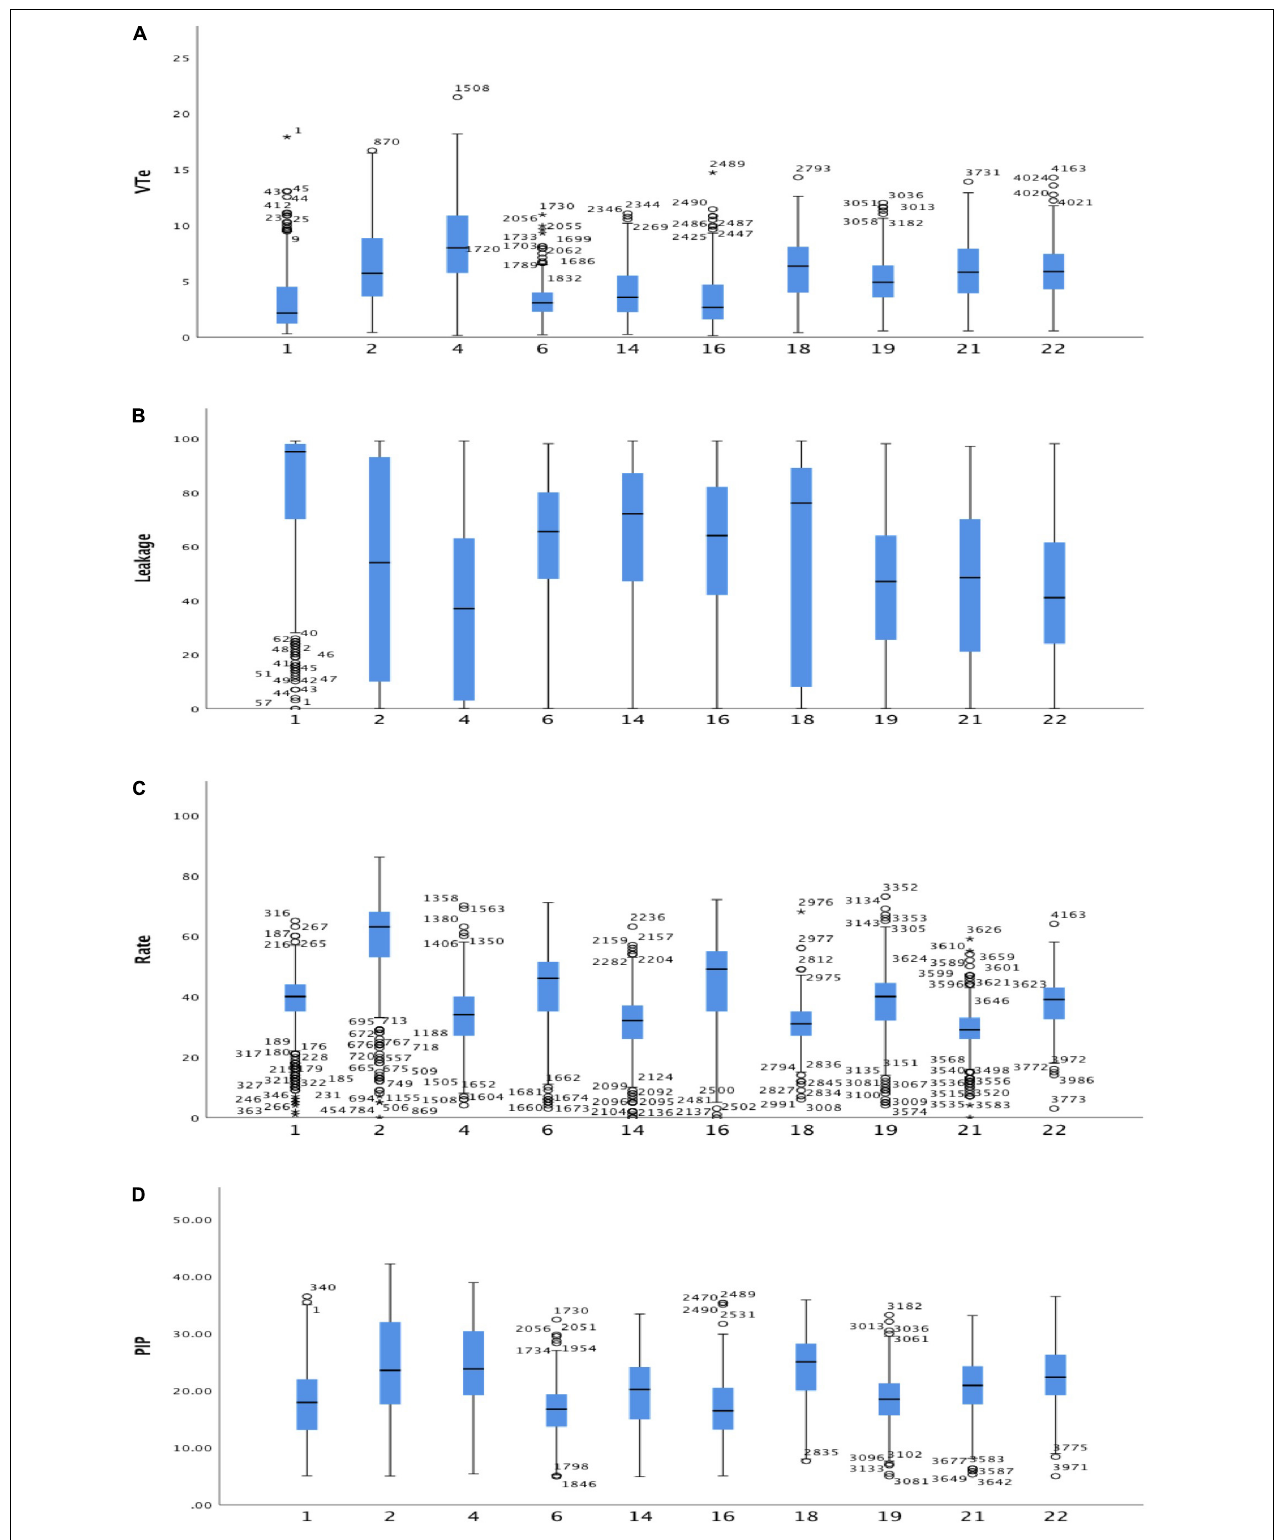
FIGURE 2 | Box plots individual students, skills training and simulation combined of (A) expiratory tidal volume (VT e , ml/kg), (B) leakage (%), (C) ventilation rate (min − 1 ), and (D) positive inspiratory pressure (PIP, cmH 2 O). Within each box, the horizontal black line represents the median value; boxes extend from the 25th to the 75th percentile; while the whiskers represent the minimum and maximum values,